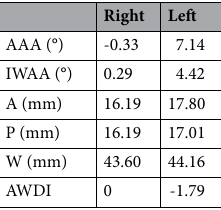
Table 7. Fig. 6-D data